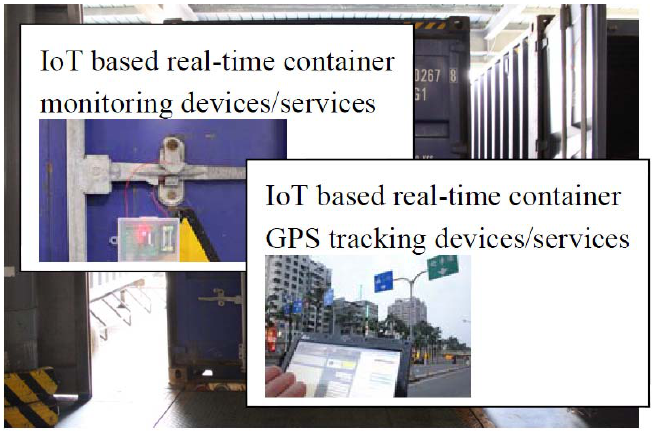
Figure 6. IoT-based container seal development and deployment in real